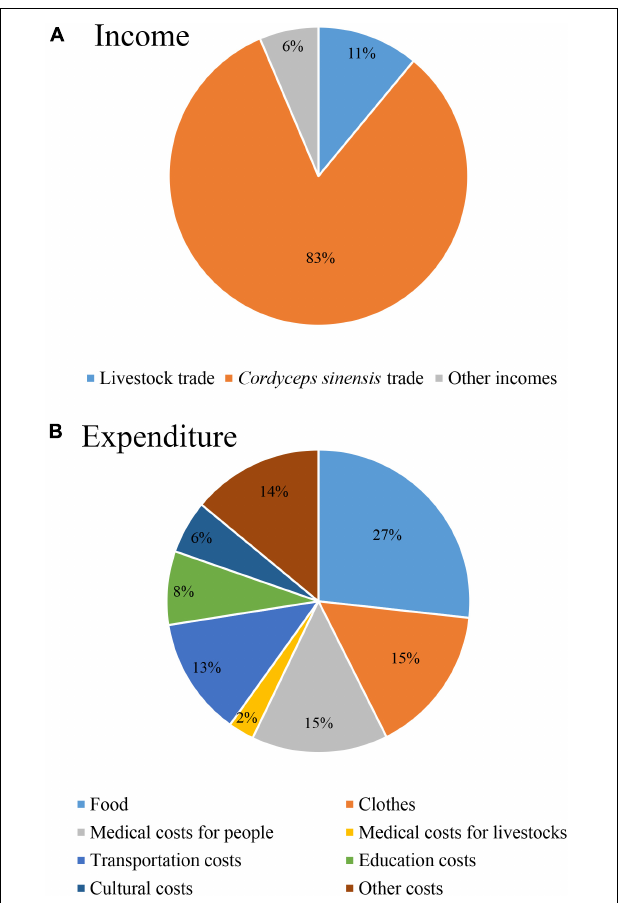
FIGURE 7 | Income (A) and expenditure (B) of local households in the